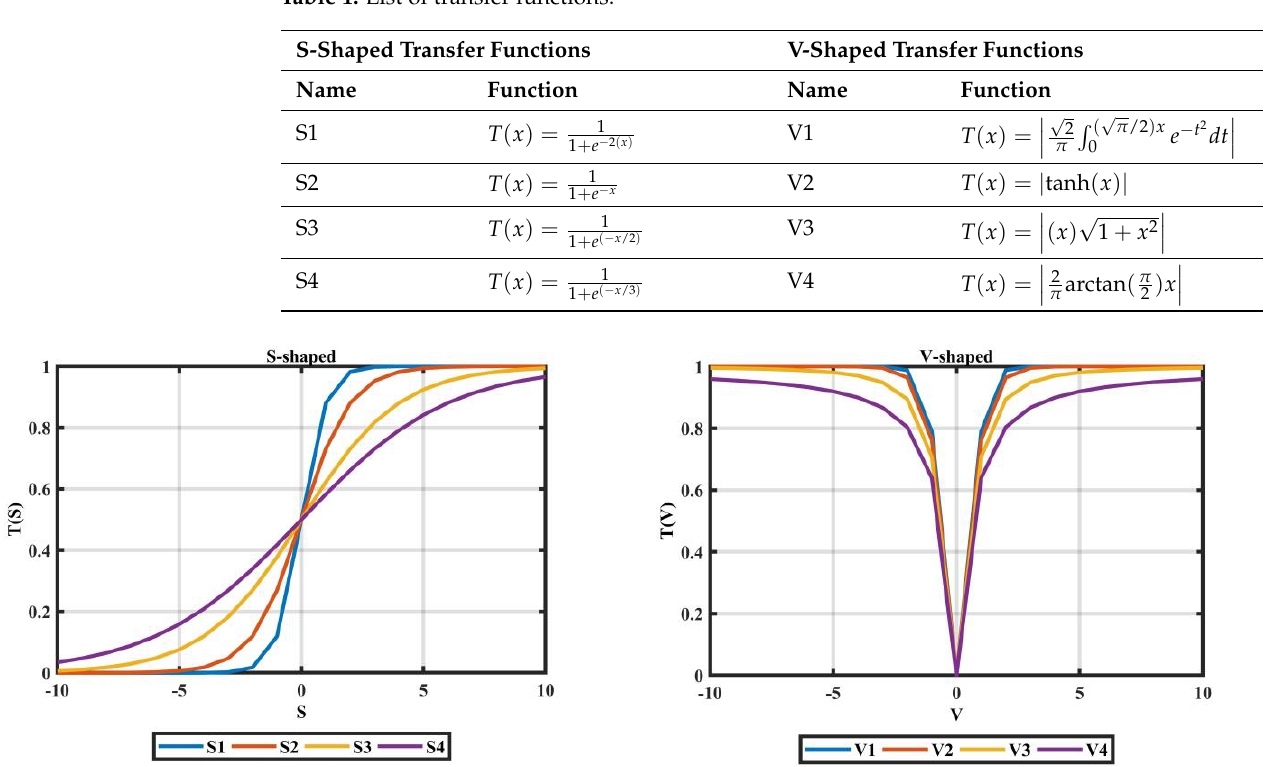
Figure 1. S-shaped and V-shaped transfer functions. Table 1. List of transfer functions.